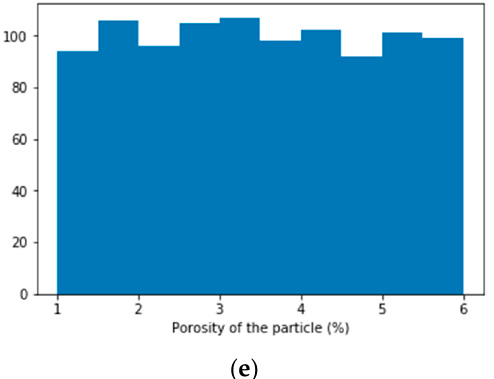
Figure 6. Distributions of independent variables high pile ( a ), particle size ( b ), surface velocity of the leaching flow through the bed ( c ), effective diffusivity of the solute within the pores of the particle ( d ) y porosity of the particle ( e ).